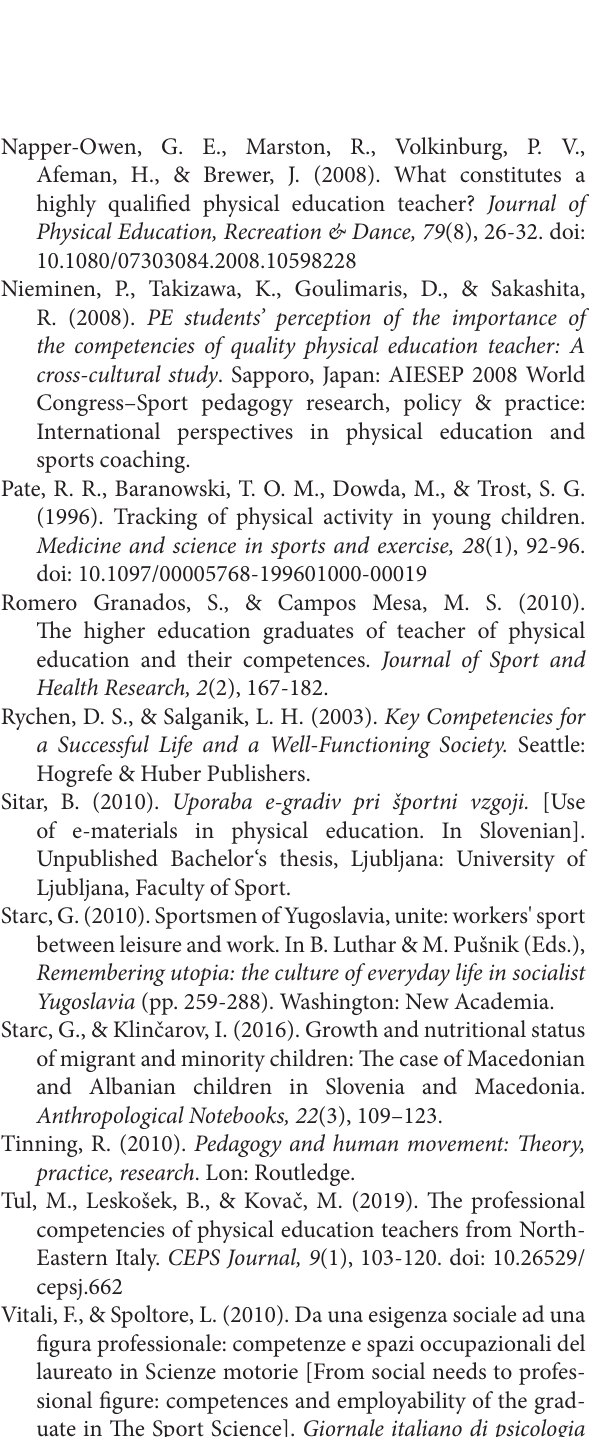
figura professionale: competenze e spazi occupazionali del laureato in Scienze motorie [From social needs to profes- sional figure: competences and employability of the grad- uate in The Sport Science]. Giornale italiano di psicologia dello sport , 8 ,